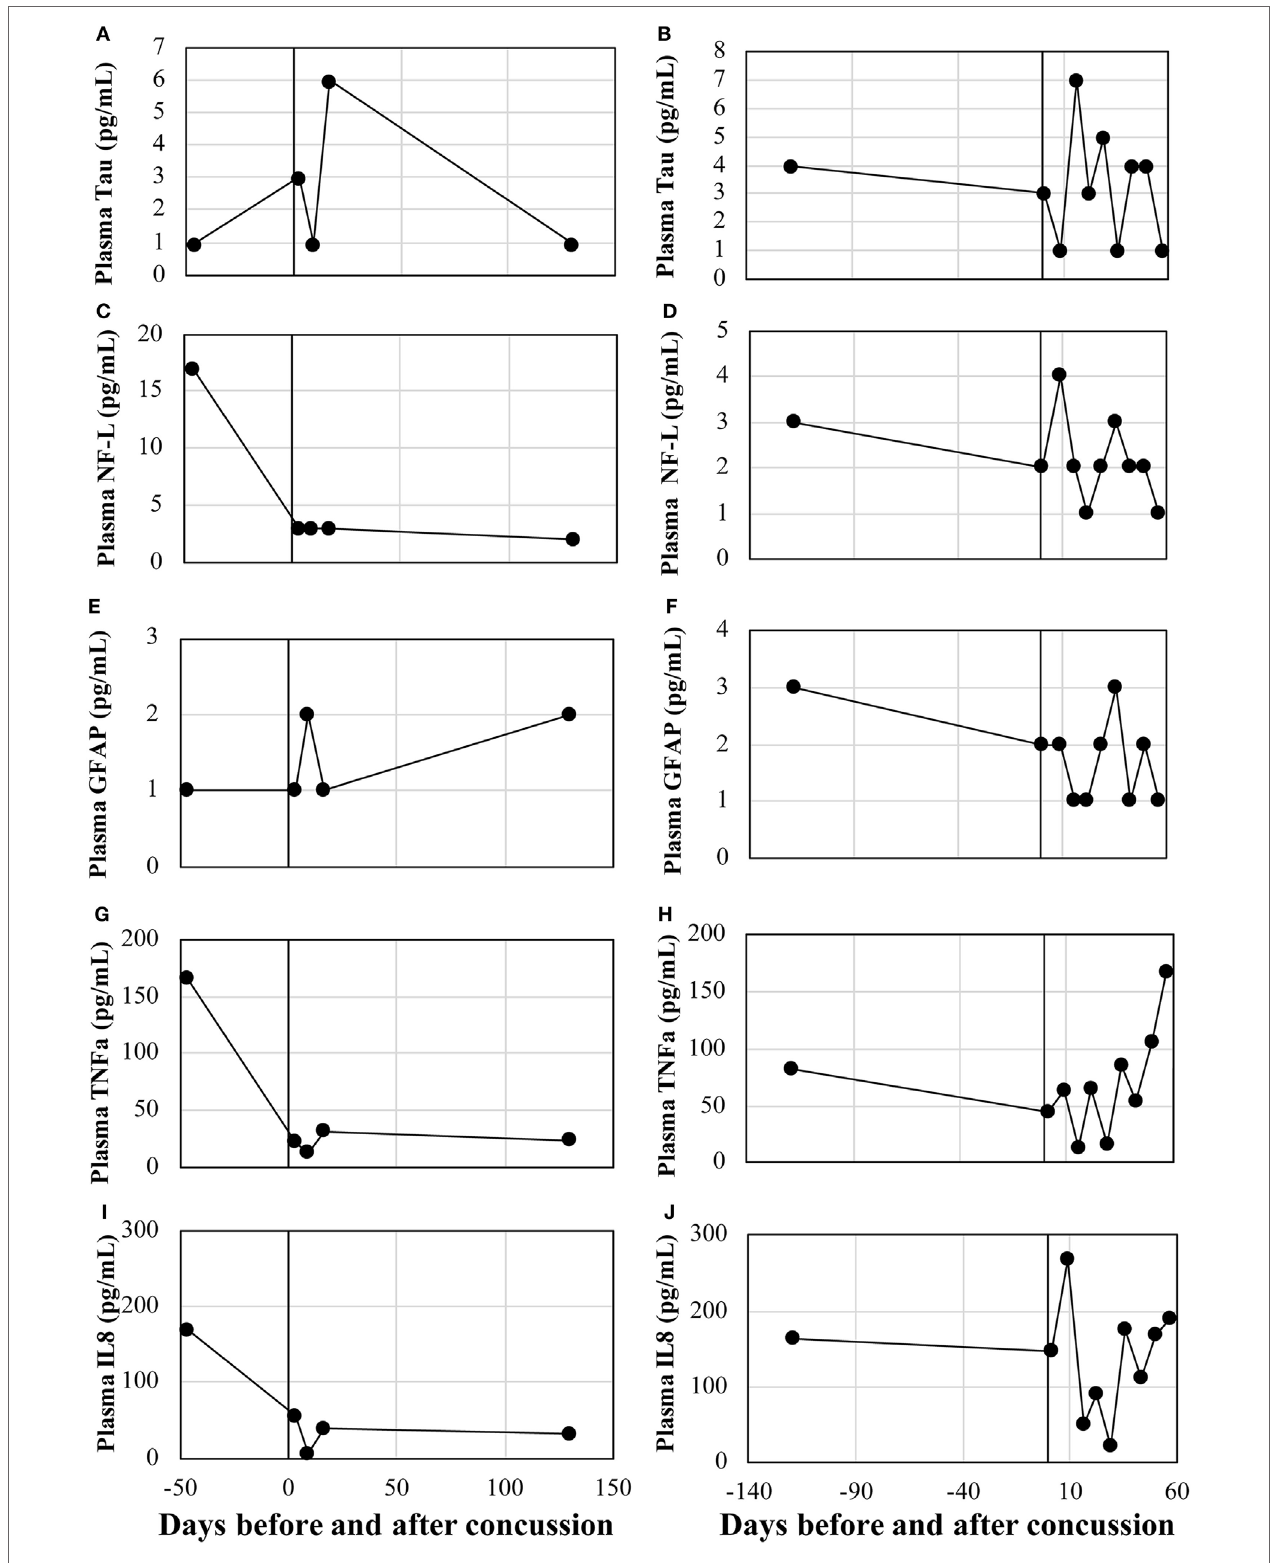
FigUre 3 | Serum levels of conventional protein biomarkers. Case 1: (a) Tau, (B) NF-L, (c) GFAP, (D) TNF α , and (e) IL8. Case 2: (F) Tau, (g) NF-L, (h) GFAP, (i) TNF α , and (J) IL8. NF-L, neurofilament light polypeptide; TNF α , tumor necrosis factor-alpha; IL8, interleukin-8; GFAP, glial fibrillary acidic